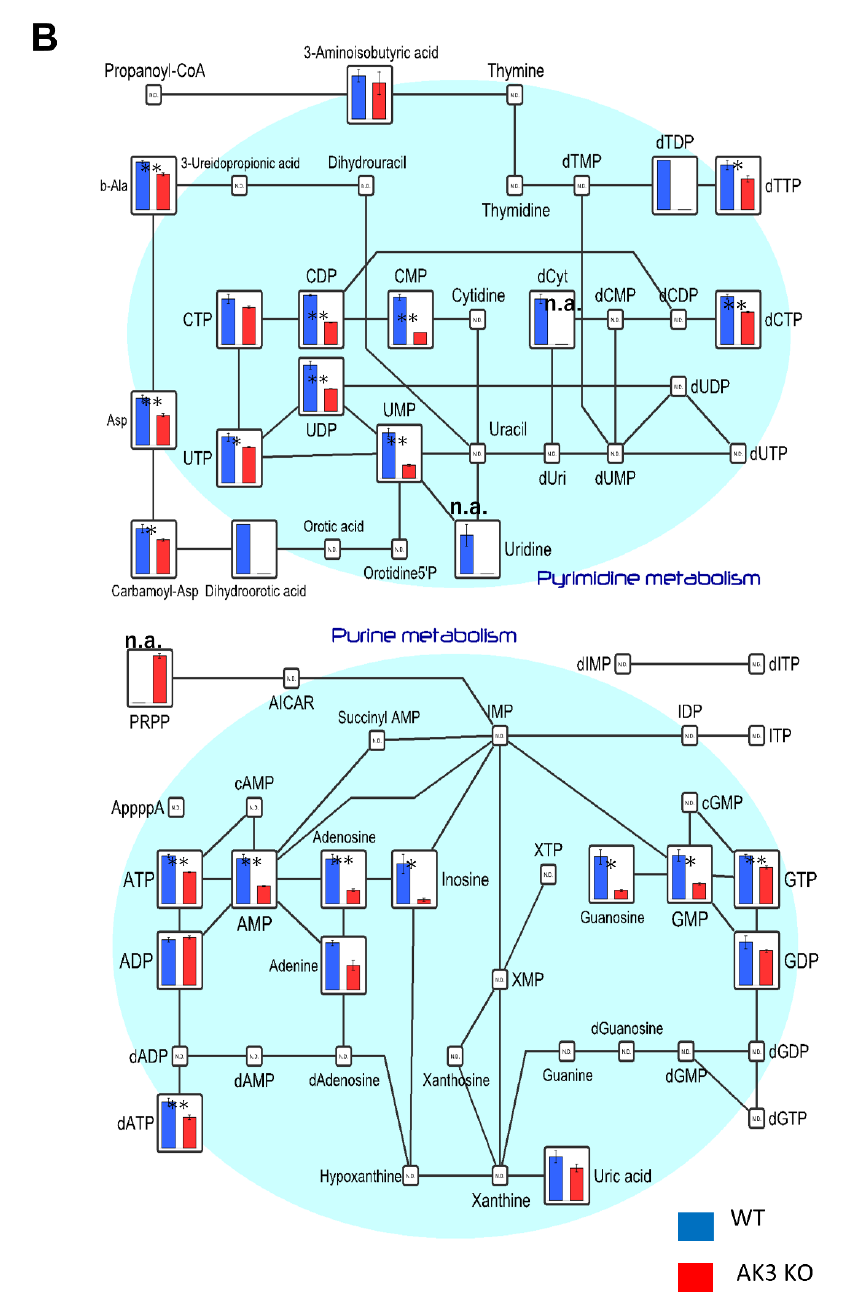
Figure 3. Changes in various metabolites shown using metabolomic analysis. ( A ) Changes in metabolites in glycolysis and the tricarboxylic acid (TCA) cycle. ( B ) Changes in metabolites associated with pyrimidine and purine. * p < 0.05, ** p < 0.01.